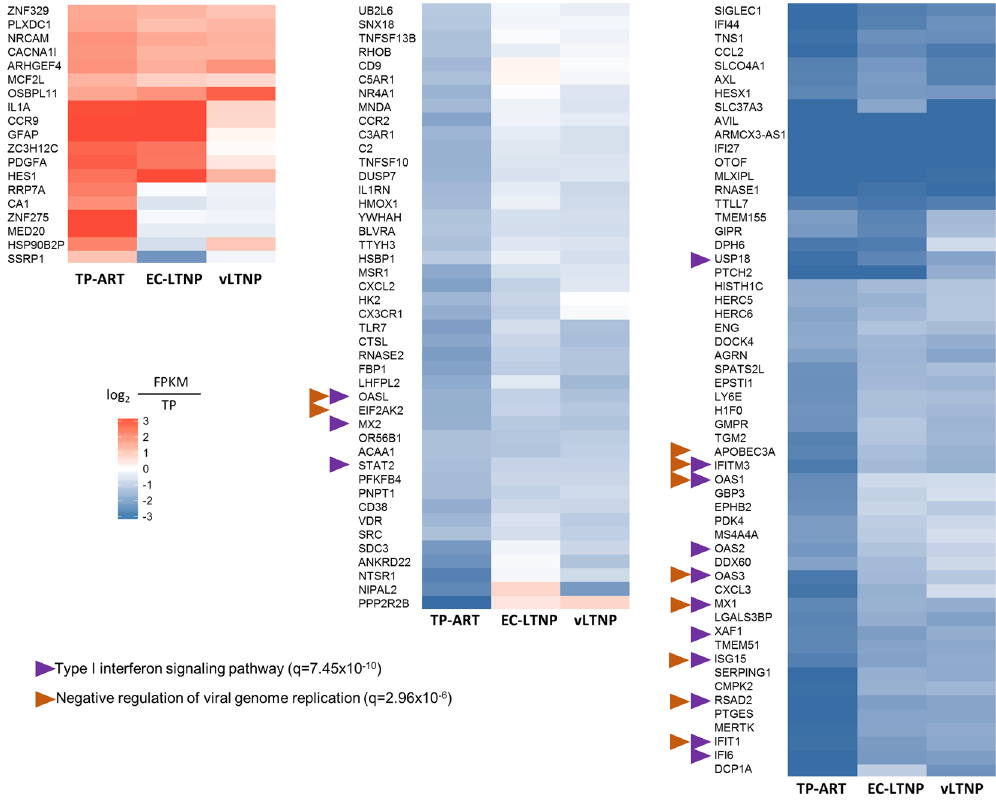
Figure 3. Deregulated genes in the TP/TP-ART comparison. Heatmap showing the comparison of the mean RPKM expression values for genes differentially expressed between TPs before and after receiving ART (the values for EC-LTNP and vLTNP were also showed just for the information). The RPKM expression values obtained for TPs, EC-LTNPs and vLTNPs are represented as a comparison with the values obtained for TPs.